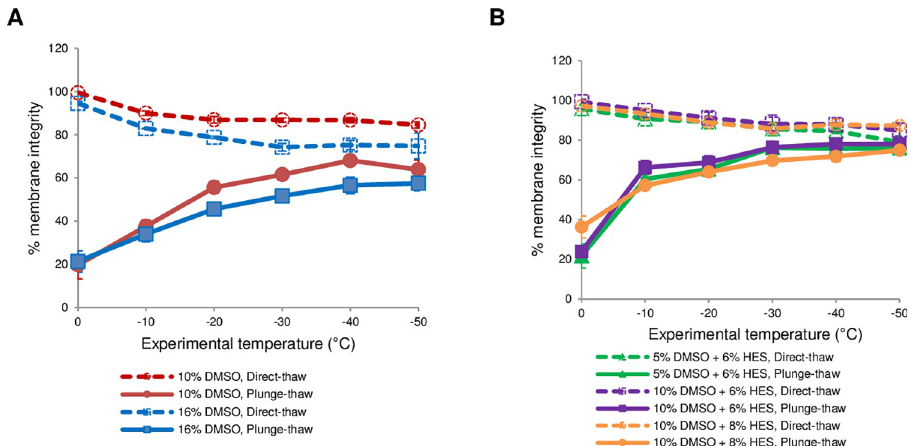
Fig 1. Membrane integrity of dispersed islet cells subjected to graded freezing. The cells were cooled to various sub- zero temperatures in the presence of different concentrations of cryoprotectants (DMSO: Dimethyl sulfoxide; HES: Hydroxyethyl starch) at 1˚C/min. The samples were either directly thawed (open symbols, broken lines) or plunged and stored in liquid nitrogen before rapid thawing (solid symbols and lines). The percent membrane integrity was normalized against live unfrozen control. Data points are the mean of independent experiments (N values) and error bars represent standard error of the mean. ( A ) Comparison between 10% DMSO (N = 3) and 16% DMSO (N = 2). ( B ) Comparison between 5% DMSO + 6% HES (N = 2), 10% DMSO + 6% HES (N = 3), and 10% DMSO + 8% HES (N = 2) (S1 Table).